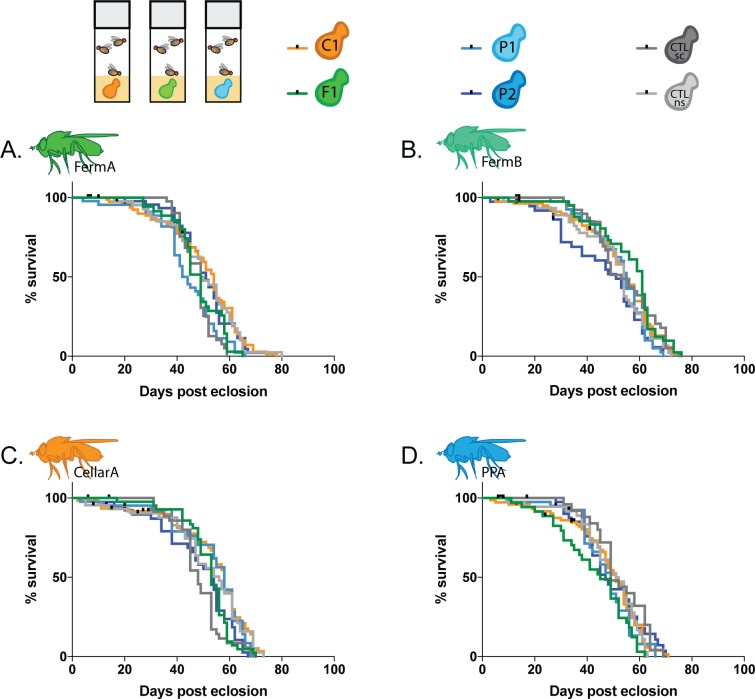
Fly-associated yeasts have no differing effects on Drosophila longevity.Accompanying statistics for longevity assay in S6 Table. Lifespan of fly lines (A) FermA (B) FermB. (C) CellarA. (D) PPA.